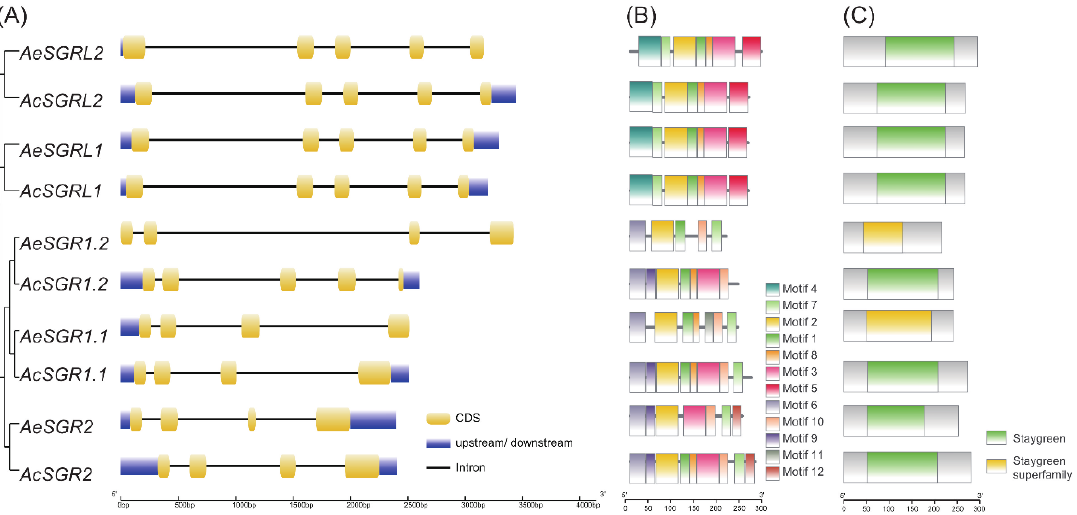
Figure 2. Gene structure and conserved motif architecture of SGR family members in two kiwifruit species. ( A ) the exon-intron structure, ( B ) the conserved motifs distribution, and ( C ) the presence of the conserved domain.